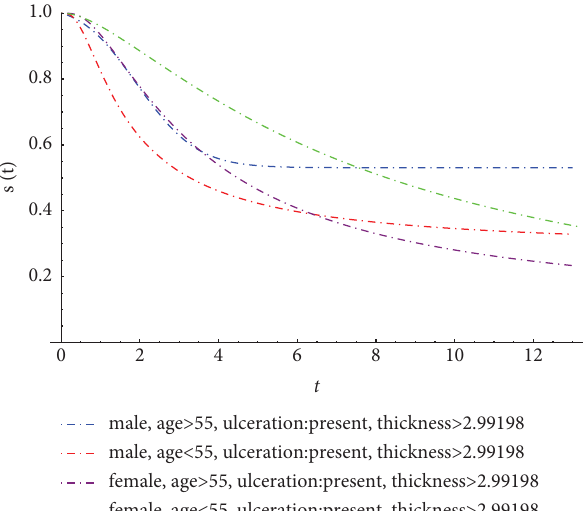
Figure 6: Plots of the survival functions for the melanoma data based on the PGcr/GeTNH model stratifed by sex: (1 � male, 0 � female), age more than 55years (0 � no, 1 � yes), tumour thickness more than 2.99198 (1 � yes), and ulceration (1: present).